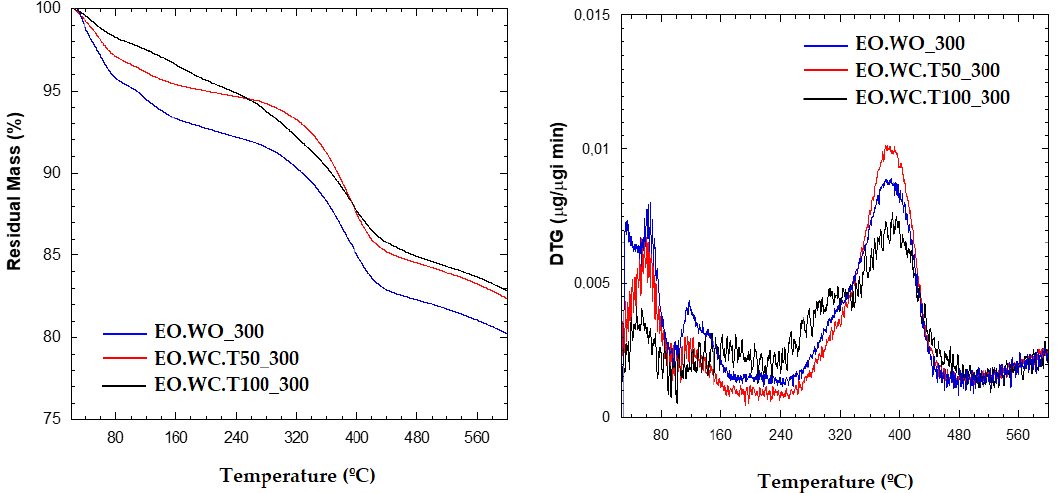
Figure 8. TGA results obtained for lemon hybrid EO systems with MMT at 300 wt% of LEO.